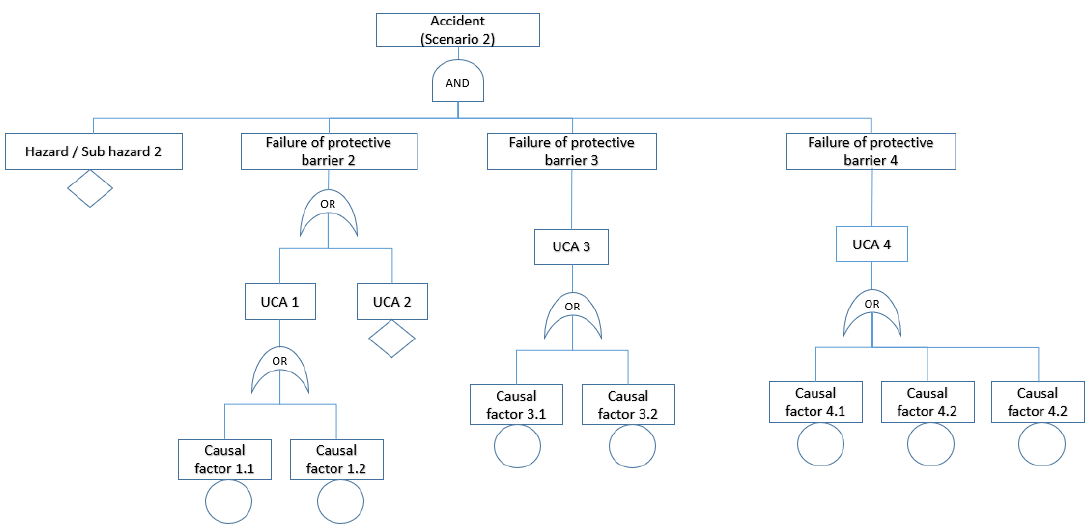
Figure 5. Populating the Fault Tree with UCAs and causal factors.